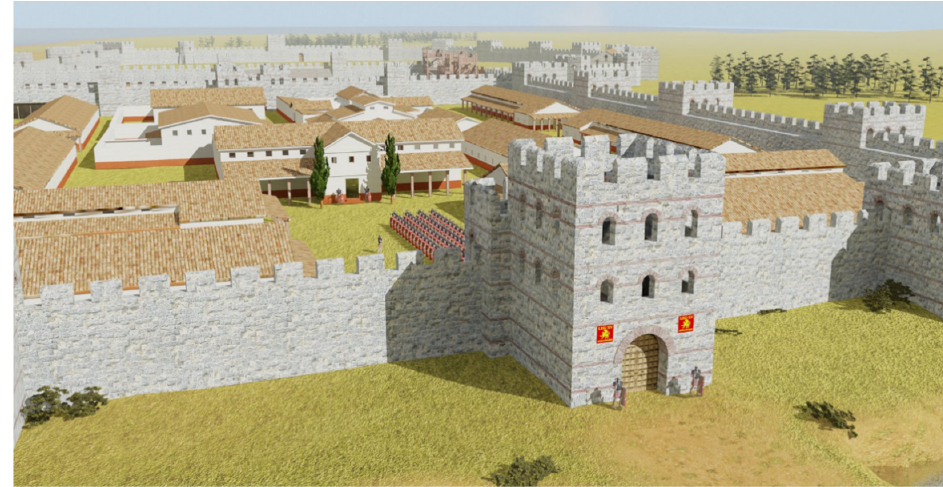
Figure 9. Reconstruction of the western gate of the fortress.